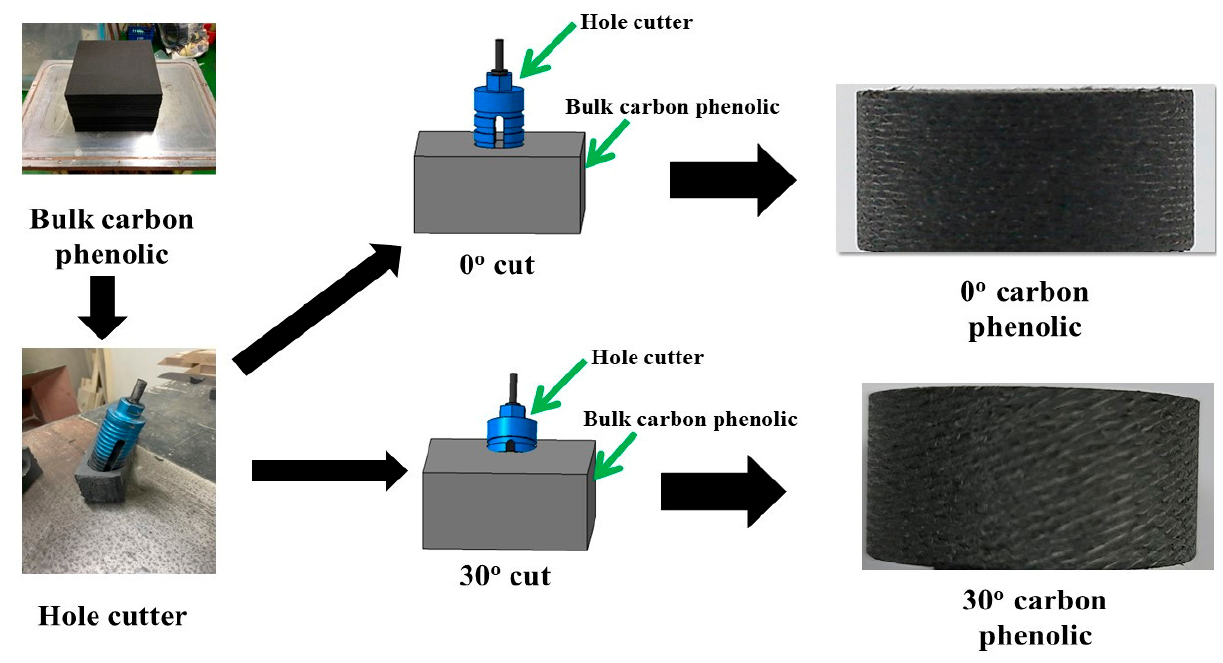
Figure 1. Carbon phenolic specimen fabrication process.